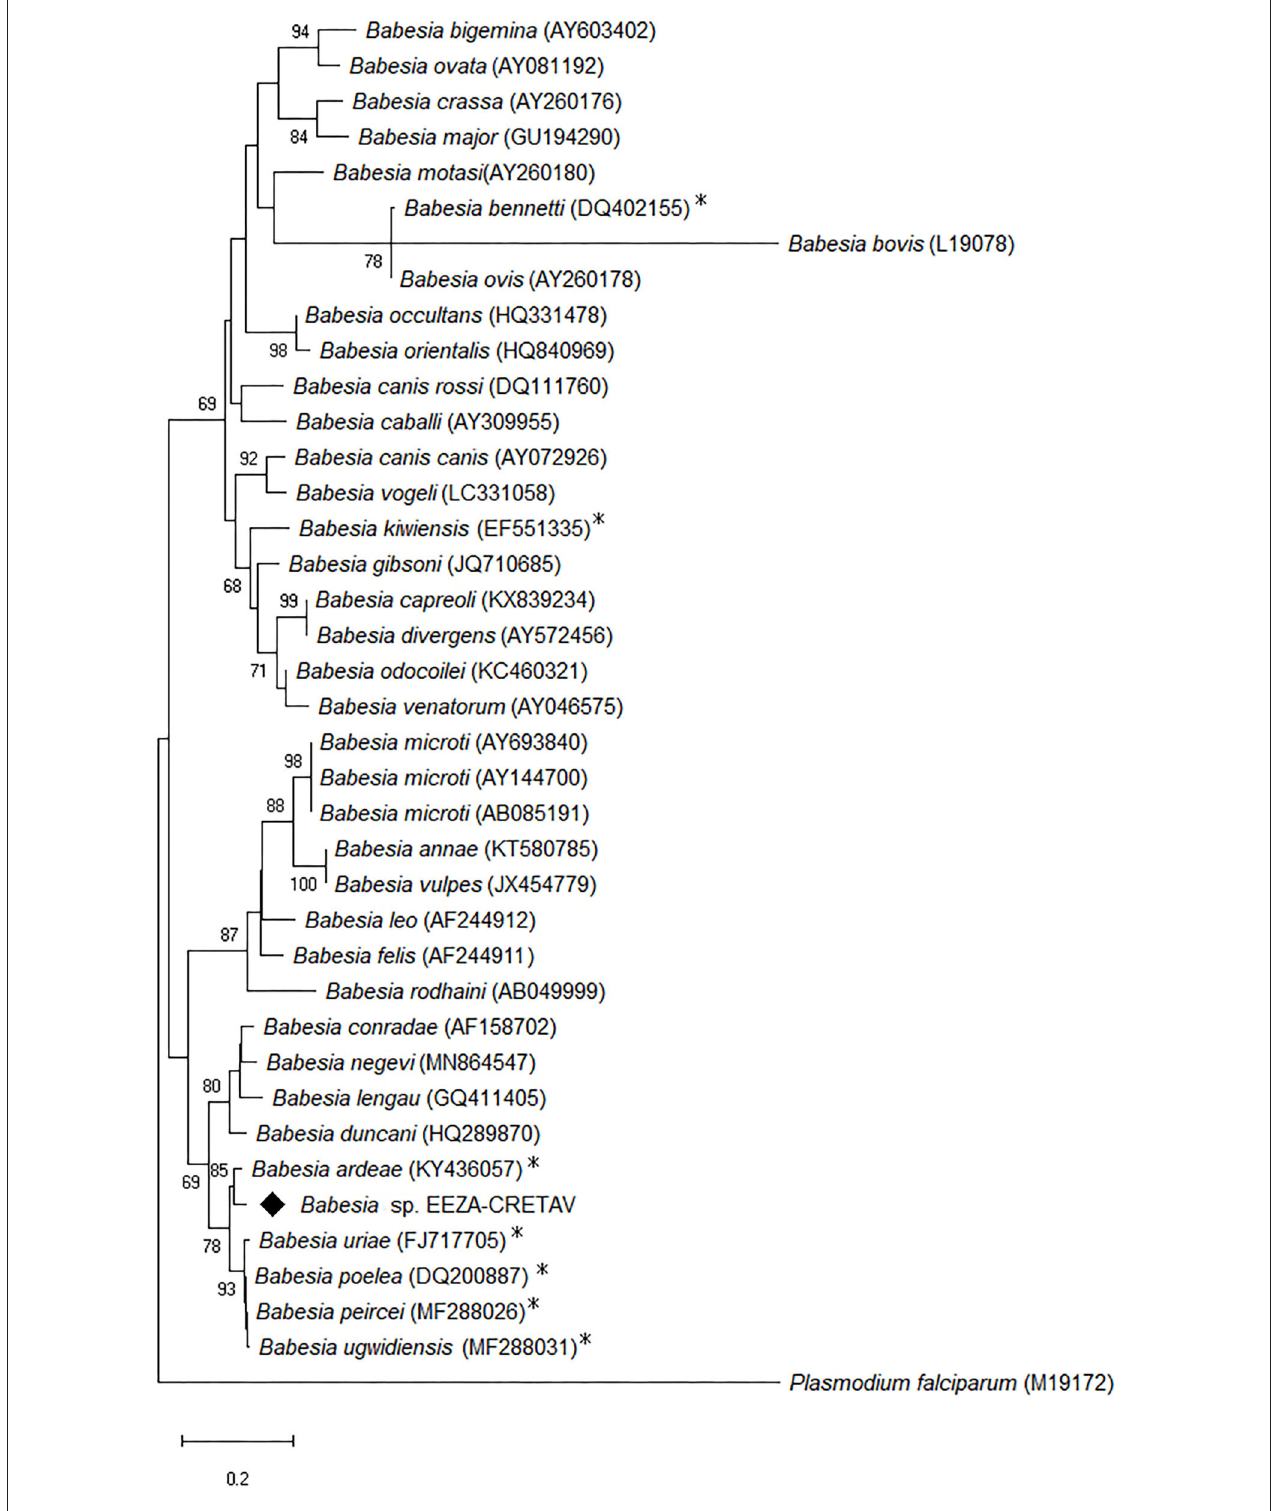
FIGURE 3 | Maximum likelihood trees of Babesia species based on 18S rRNA analysis. The evolutionary analysis was inferred using Tamura-Nei model + G model with Mega X. The analysis involved 39 nucleotide sequences and a total of 483 positions in the final dataset. The tree is drawn to scale, with branch